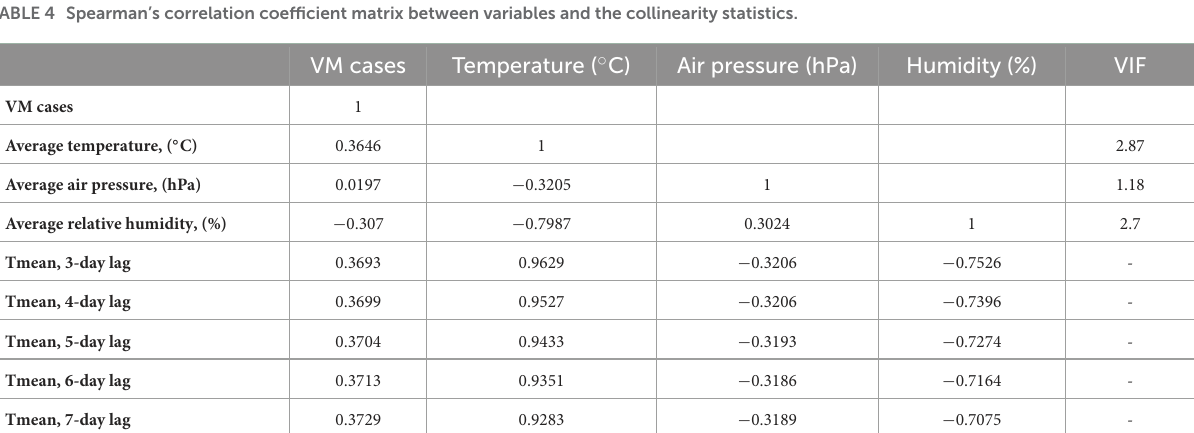
TABLE 4 Spearman’s correlation coefficient matrix between variables and the collinearity